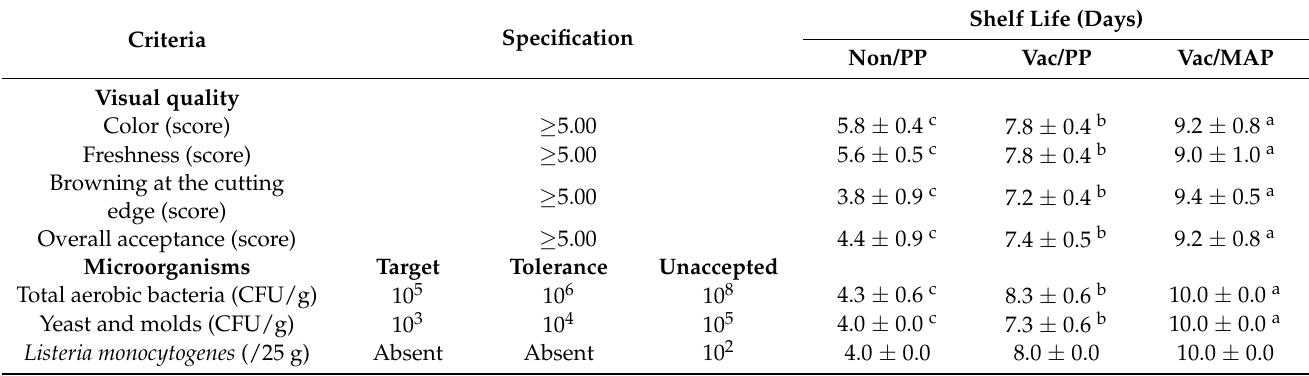
Table 3. Estimated shelf life of the whole packaged fresh-cut vegetables during storage at 4 ◦